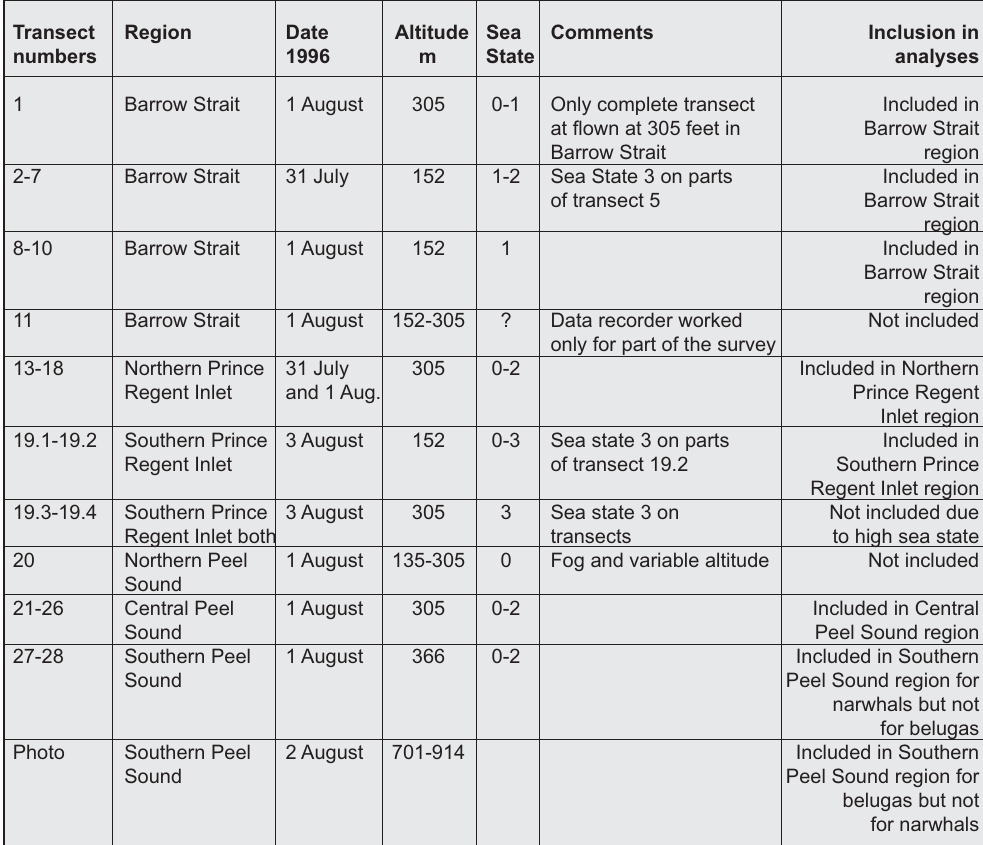
Table 1 . Transect lines split by regions with data on changes in altitude and sea states and the use of the transects in the